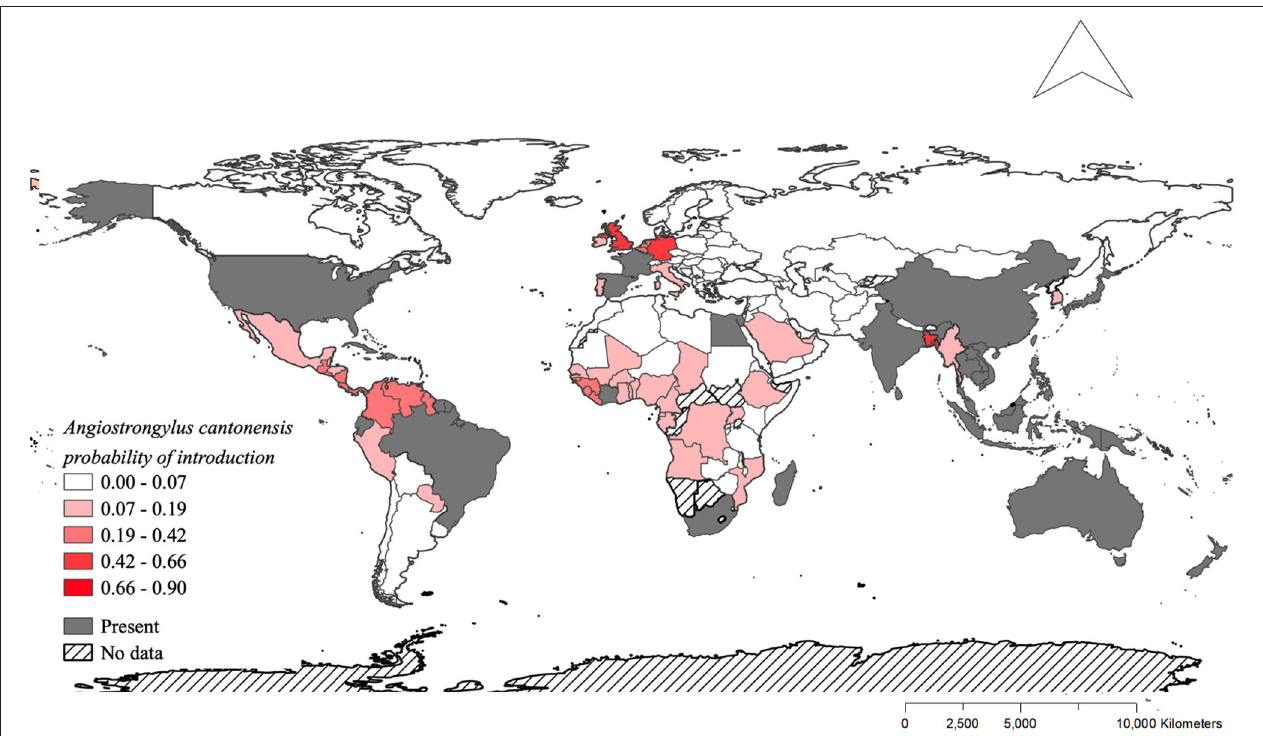
FIGURE 2 | Distribution of Angiostrongylus cantonensis and predicted probabilities of future introduction. Shades of red indicate the probabilities of future introduction based on the fitted model for exported vegetables ( Figure 1C ). Gray indicates the countries where A. cantonensis is already present, and hashed pattern indicates the countries that were not included in the model due to the absence of data.